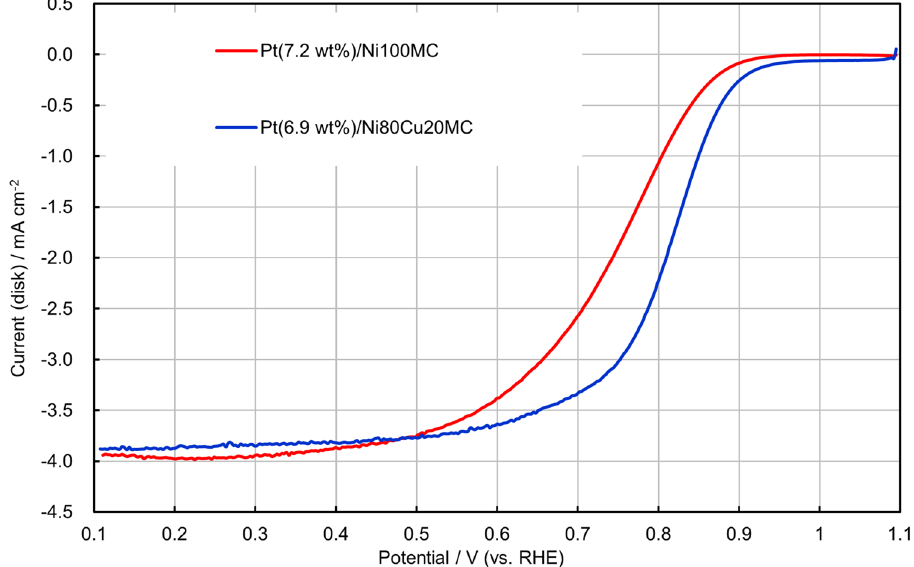
Fig. 7 Rotating ring-disk electrode voltammograms for the oxygen reduction reaction in an O -saturated 2 0.1-M HClO solution over Pt- 4 loaded Ni100MC (Pt(7.2 wt%) Ni100MC; red line) and Pt(6.9 wt%)Ni80Cu20MC (blue